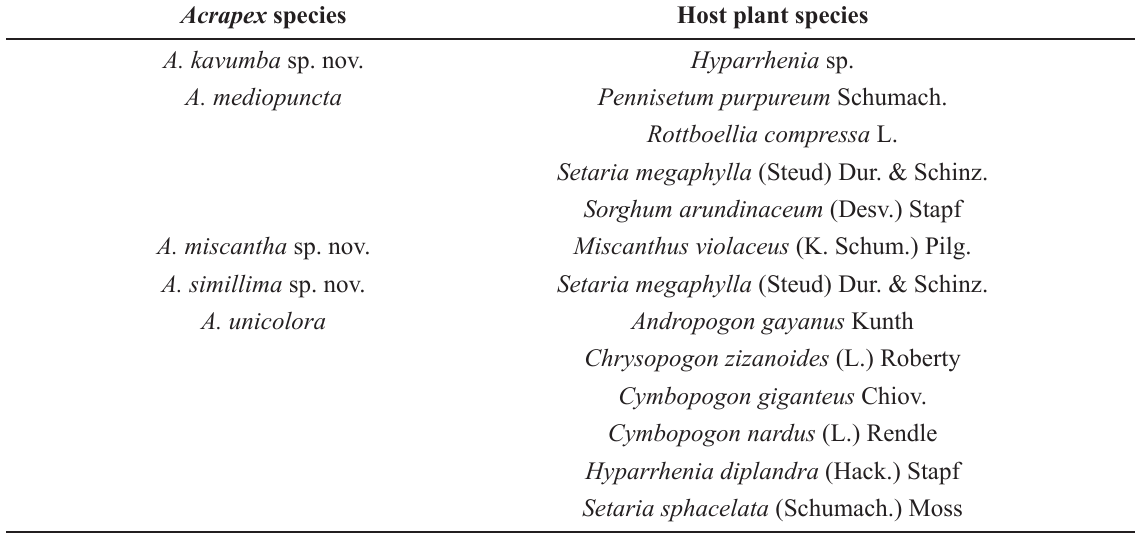
Table 3. Host plants on which larvae of the Acrapex unicolora group were